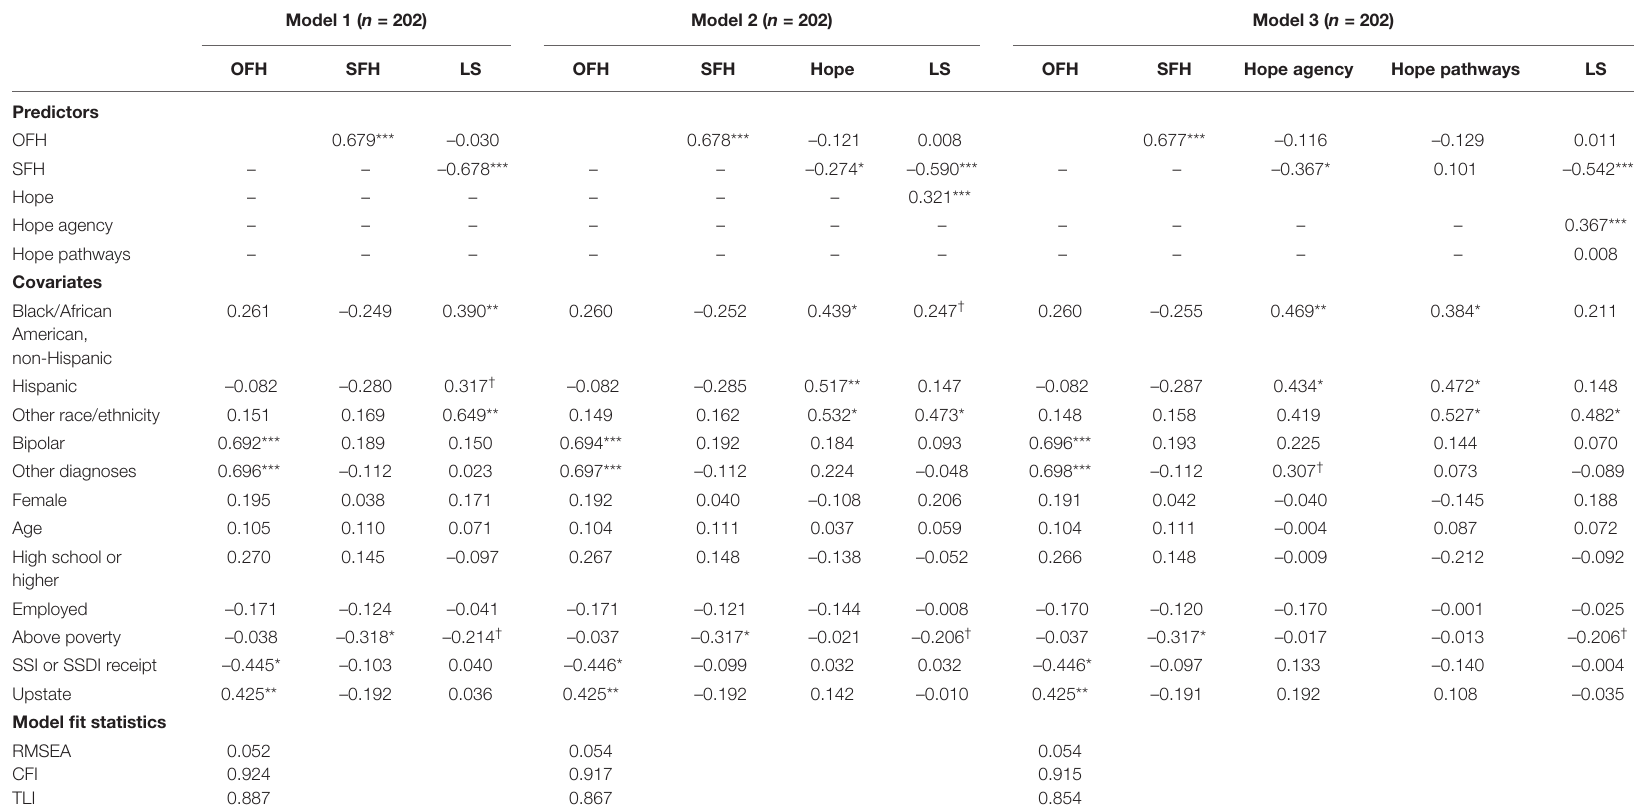
TABLE 4 | Standardized coefficients for predictors and socio-demographic covariates ( N =